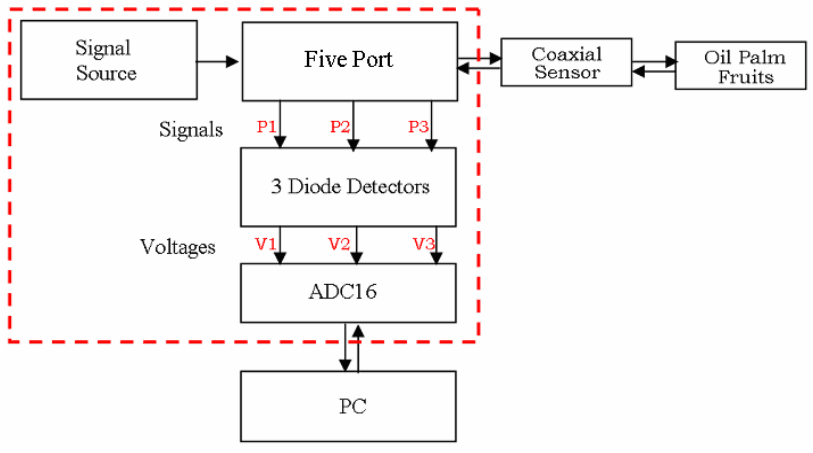
Figure 1. Five-port reflectometer. (a) five-port reflectometer measurement setup; (b) photo of five-port reflectometer; (c) five-port reflectometer main